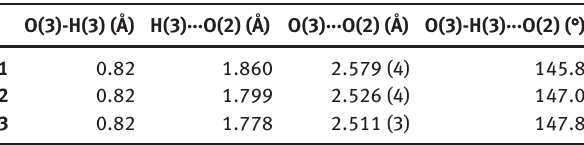
Table 2: Hydrogen bond O(3)-H(3)···O(2) distances in compounds 1–3 .